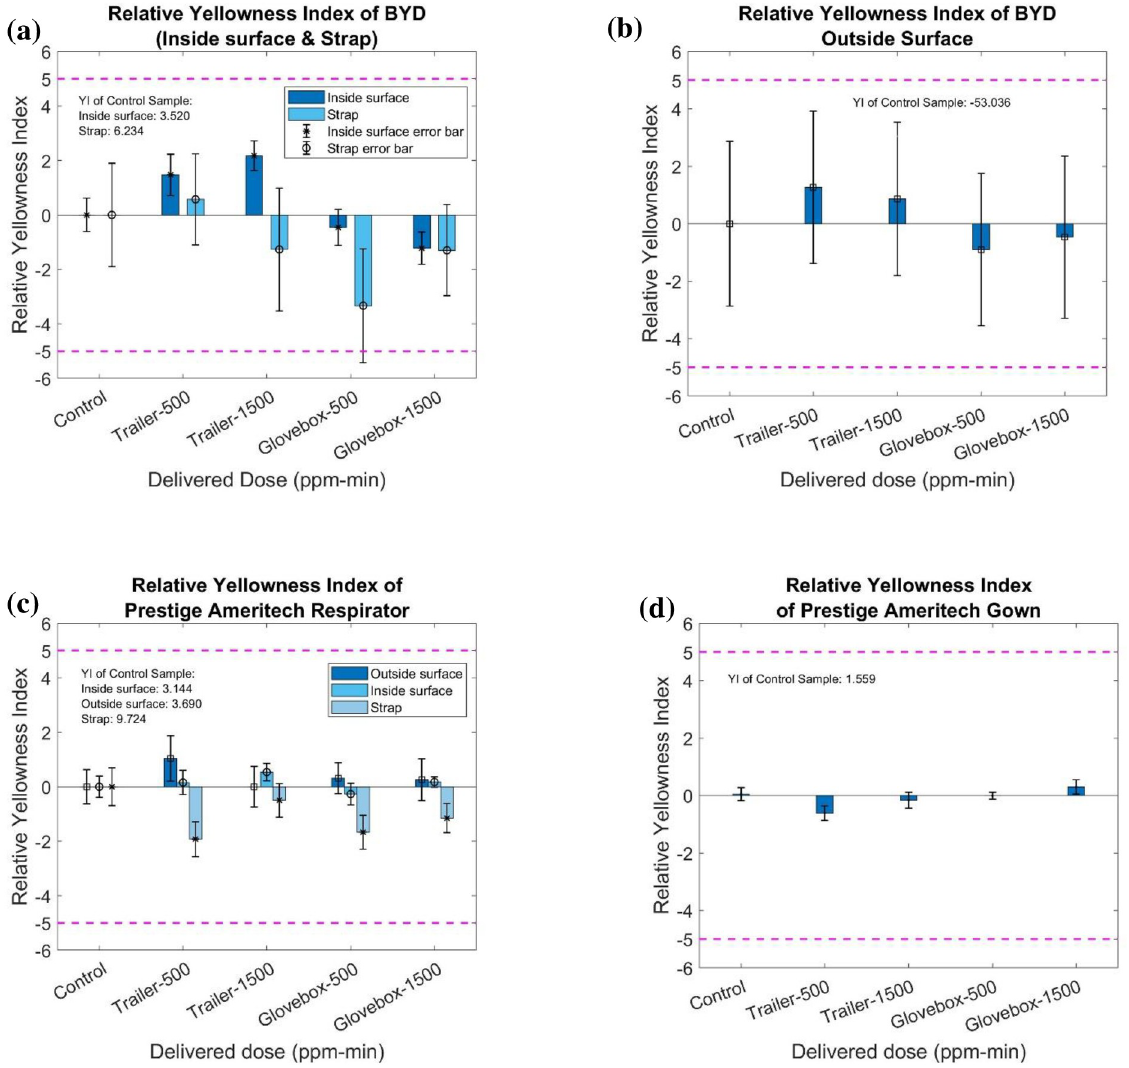
Fig 17. Yellowness index of (a) the BYD respirator inside surface and strap, (b) BYD respirator outside surface, (c) Prestige Ameritech respirators and strap, and (d) Prestige Ameritech gown treated by plasma ROS.